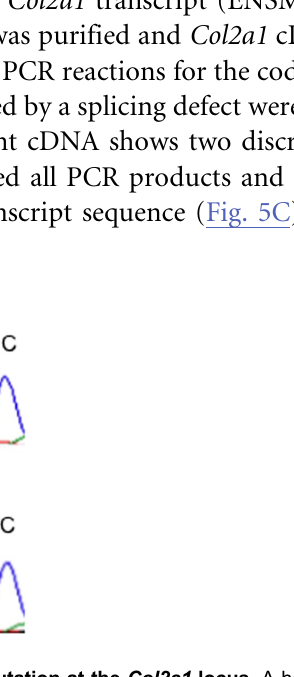
Fig. 4. Sanger sequencing of an ENU mutation at the Col2a1 locus. A heterozygous sample shows the wild type (G) and ENU mutant allele (A). Mutant DNA is homozygous for the ENU variant (A). The ENU mutant locus is boxed and the exon 21 sequence is indicated in